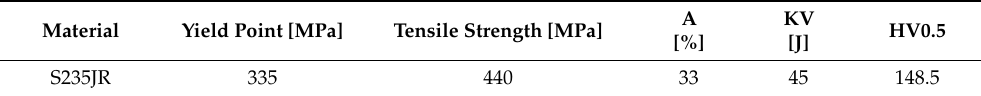
Table 2. Properties of S235JR.